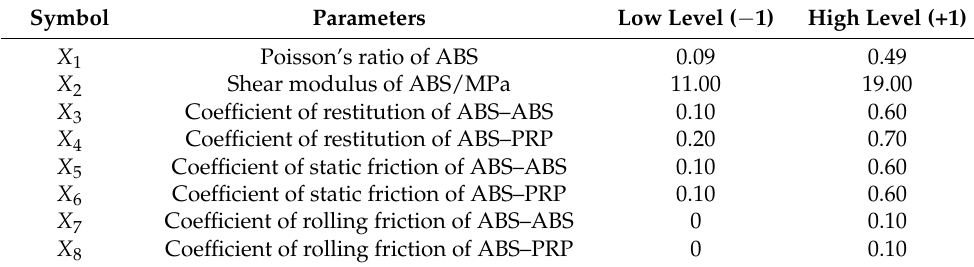
Table 2. Plackett–Burman test